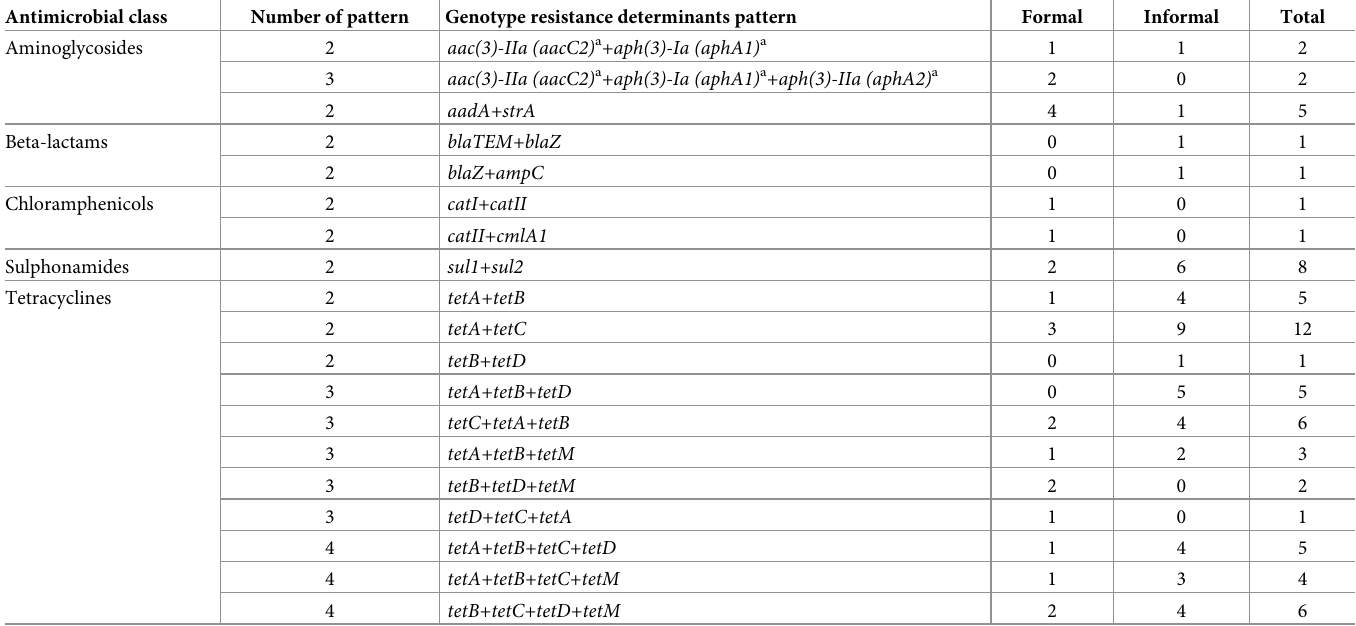
Table 5. Genotypic resistance determinants pattern of E . coli isolates from the formal and informal meat sector. Antimicrobial